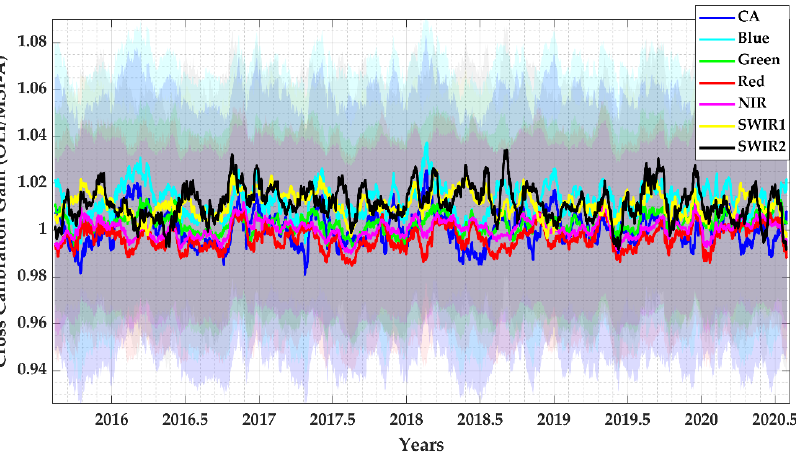
Figure 11. The trend-to-trend cross-calibration gain of Landsat 8 OLI and Sentinel 2A MSI. The shaded region is the uncertainty for individual bands.